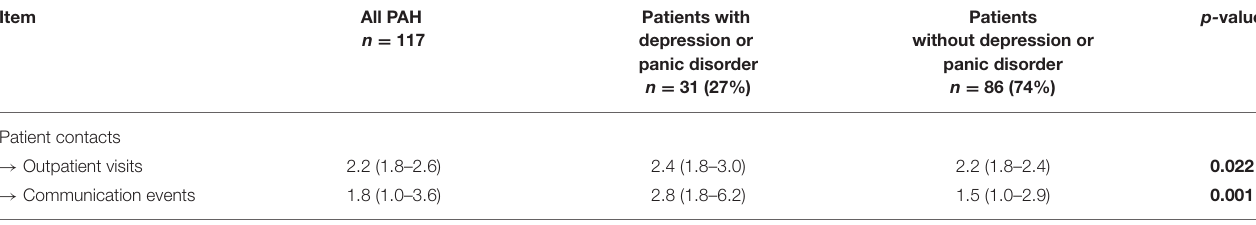
TABLE 2 | Comparison of patient contacts and communication events by mental